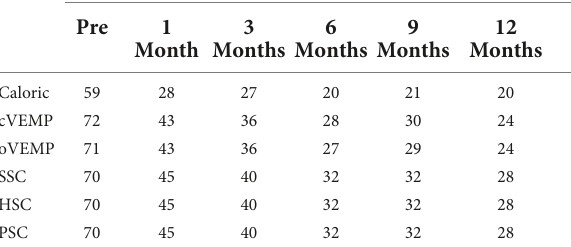
different time points Of the 72 patients, 25 were evaluated with all four assessments before CI and 1 month after CI. Caloric responses in CI ears were normal in 18 cases pre-operatively and abnormal in 44.44% (8/18) of cases 1 month post-operatively. Similarly, the percent fail rates were 27.27% (6/22) for cVEMP, 47.62% (10/21) for oVEMP, 8.33% (2/24) for SSC, 16.00% (4/25) for vHIT of HSC, and 8.33% (2/24) for PSC at 1 month post-operatively. The TABLE 2 Summary the number of patients tested at all the time points. Tests Number of patients tested among all 72